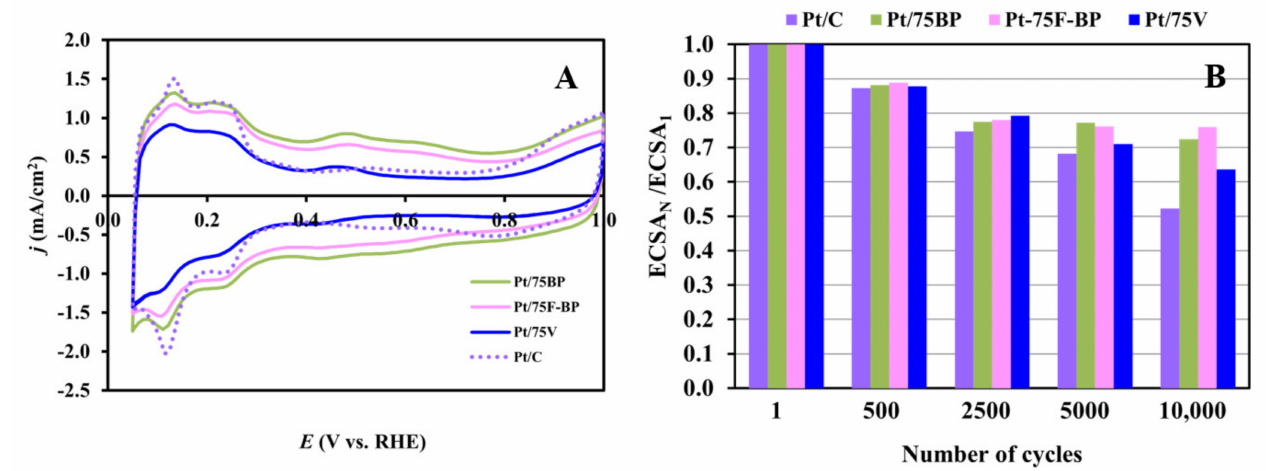
Figure 10. Cyclic voltammograms of the 20 wt.% Pt/75Ti 0.8 Mo 0.2 O 2 -25C electrocatalysts ( A ) and the results of the electrochemical long-term stability test; ( B ) comparison of the electrochemically active Pt surface area measured after N cycles, normalized to the ECSA measured in the 1st cycle (ECSA N /ECSA 1 ) for the Pt/75BP (green), Pt/75F-BP (pink), and Pt/75V (dark blue) catalysts, as a function of the number of cycles (N); results obtained on the reference Pt/C catalyst (violet) are given for comparison. Recorded in 0.5 M H 2 SO 4 at 100 mV · s − 1 , T = 25 ◦ C.